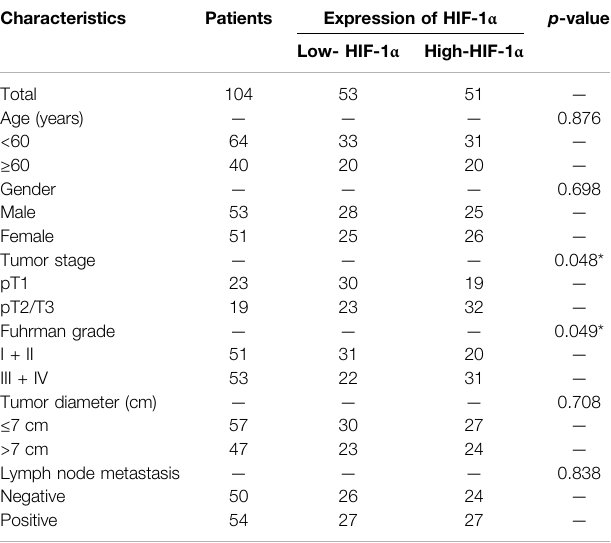
TABLE 2 | Correlation between HIF-1 α expression and clinical features in RCC patients.